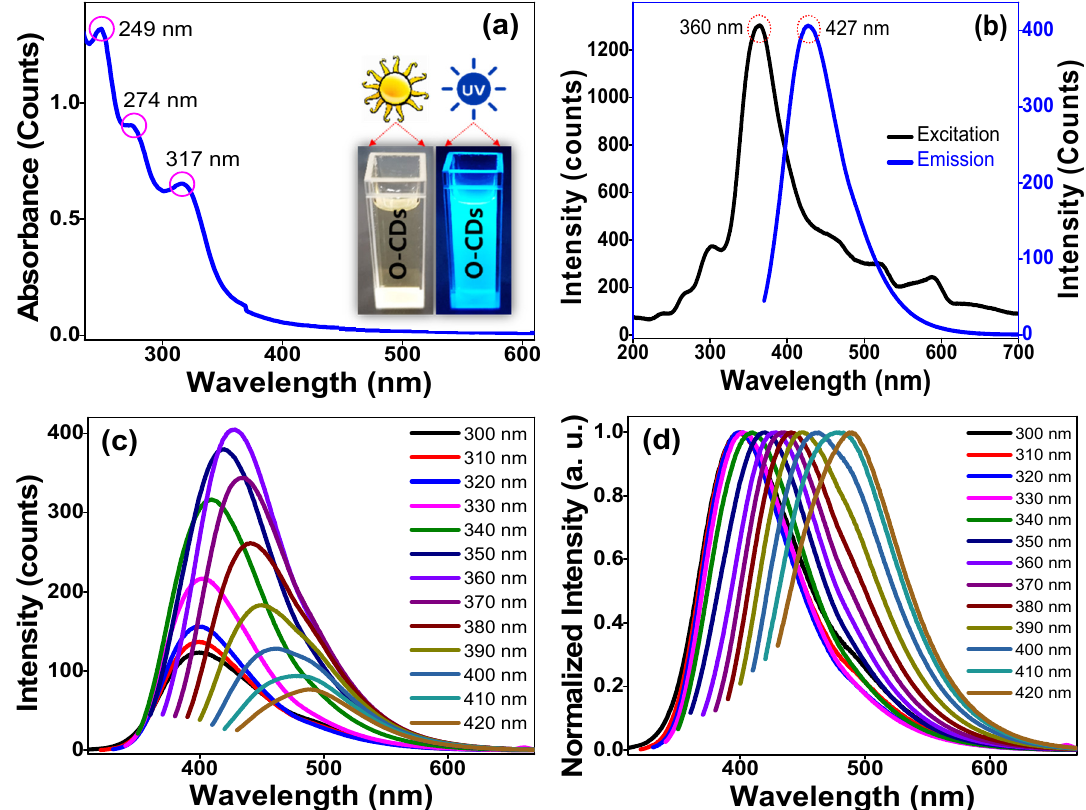
Figure 4. ( a ) UV-visible absorbance spectrum (inset: O -CDs aqueous solution under the illumination of daylight and 365 nm UV light), ( b ) excitation and emission spectra, ( c ) excitation-dependent emission spectra, and ( d ) the corresponding excitation-dependent normalized emission spectra of the synthesized hydrophilic O -CDs.